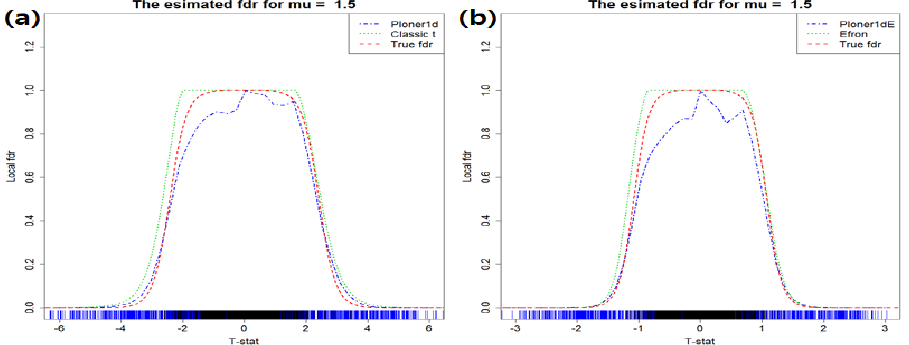
Figure 5. Mean shift scenario and two-sided. Estimated fdr1ds by ( a ) Classic t and Ploner1d ( b ) Efron and Ploner1dE when µ = 1.5.